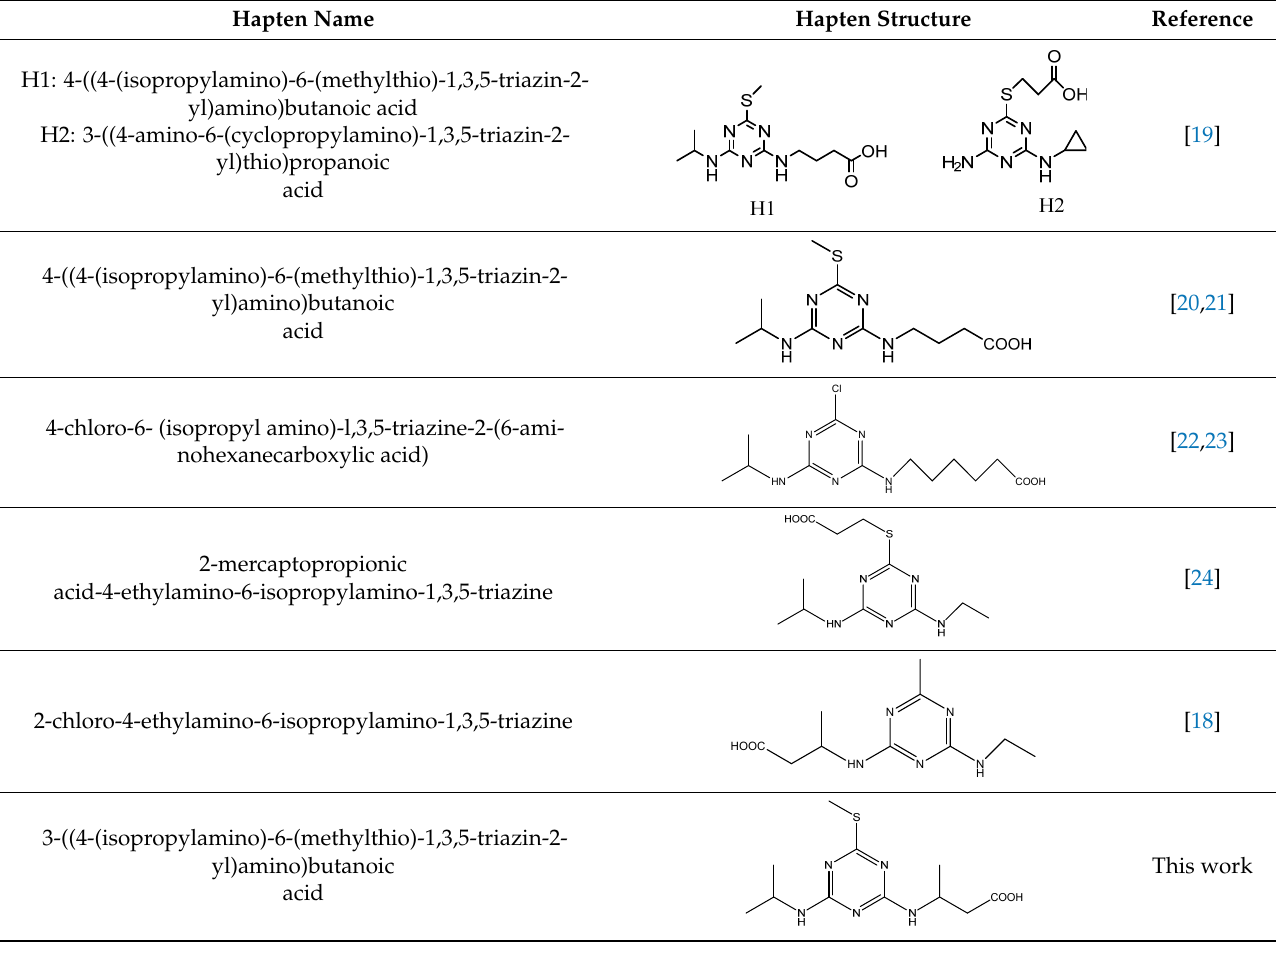
Table 2. The hapten structure of triazine pesticides.